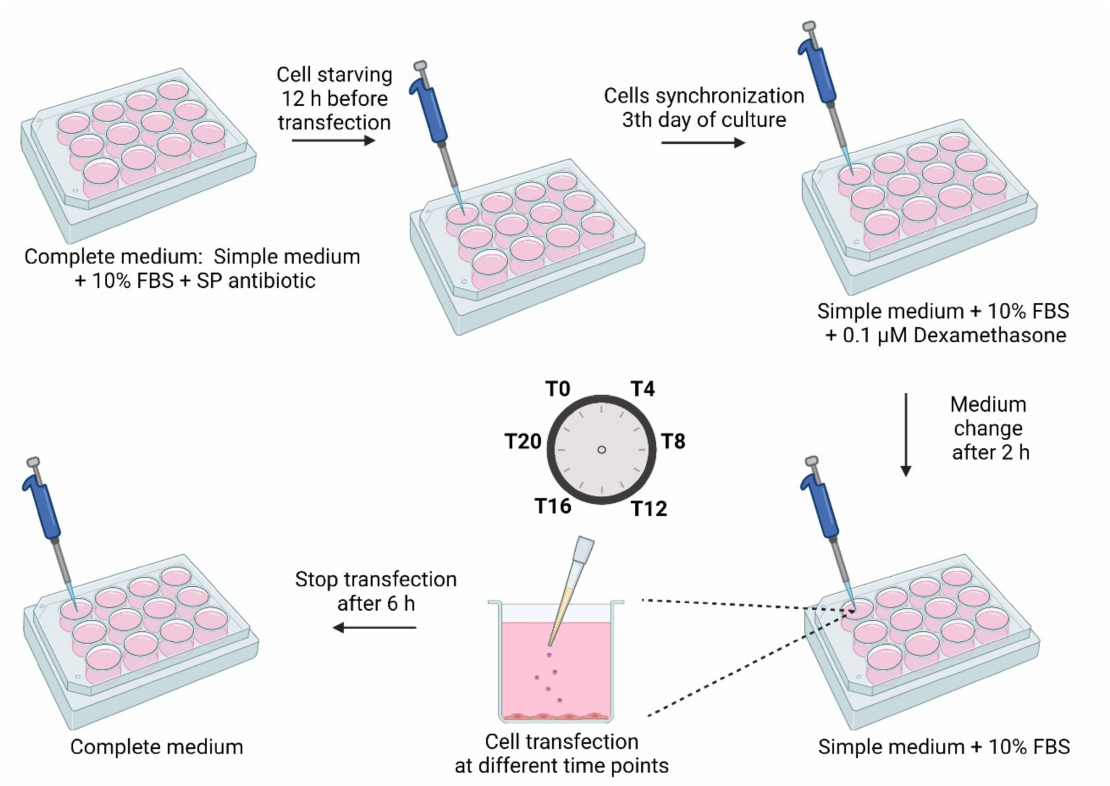
Figure 1. Schematic representation of the synchronization of cells and the transfection